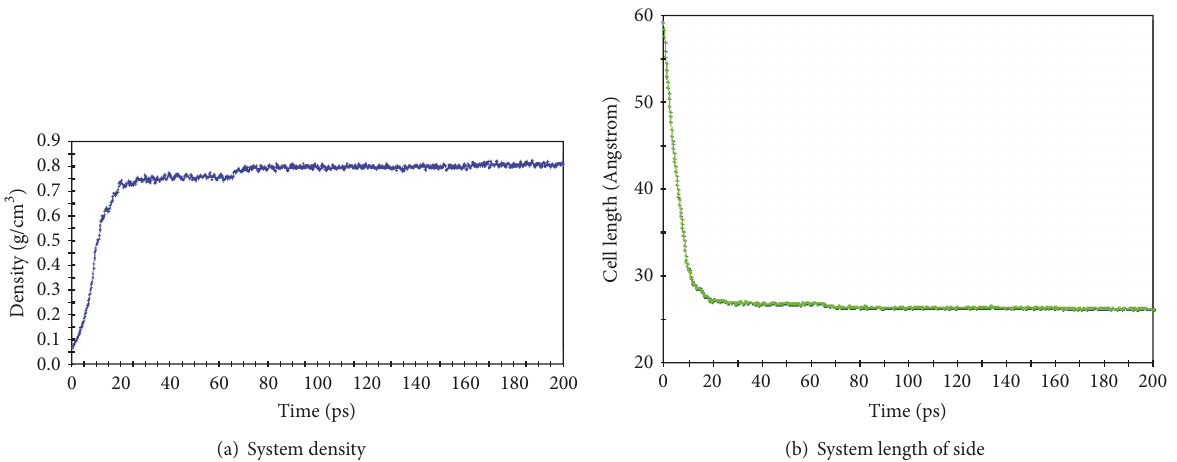
Figure 14: Change of (a) system density and (b) system length of side with time at 0.06 GPa.